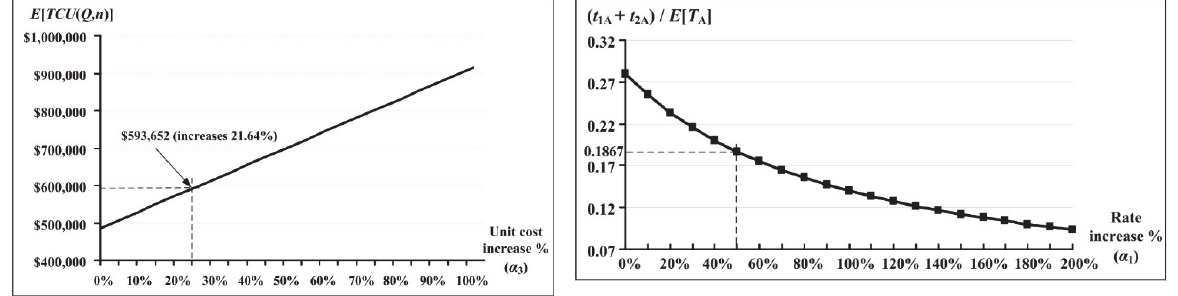
Fig. 11. The impact of variations in overtime output adjusted rate α 1 on machine